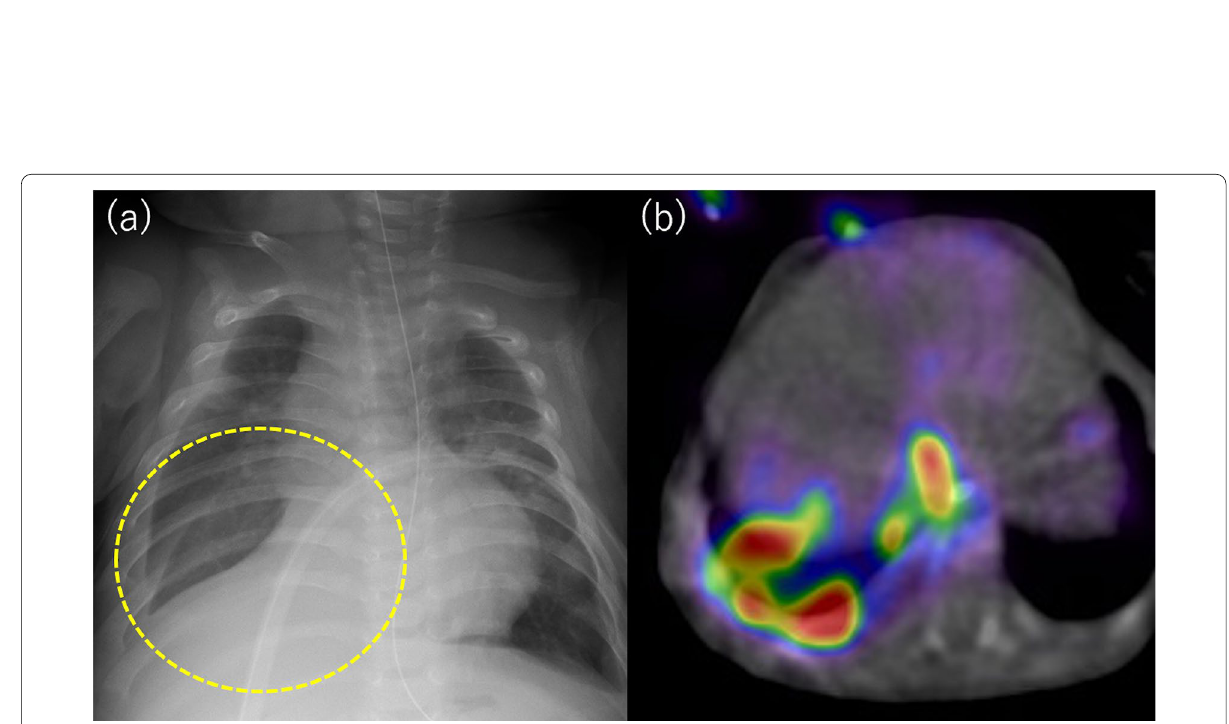
Fig. 4 a A chest radiograph showed a right-sided hydrothorax. b Preoperative scintigraphy demonstrating the radioactive dialysate in the thoracic cavity confirming a